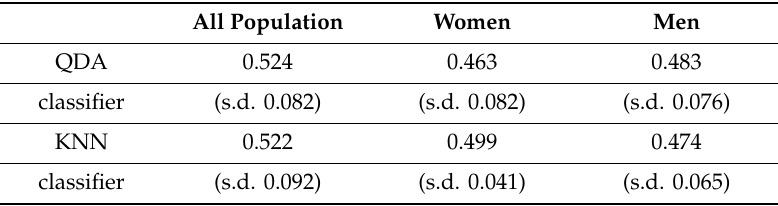
Table 2. SI classification F1 scores based on our EEG model *.